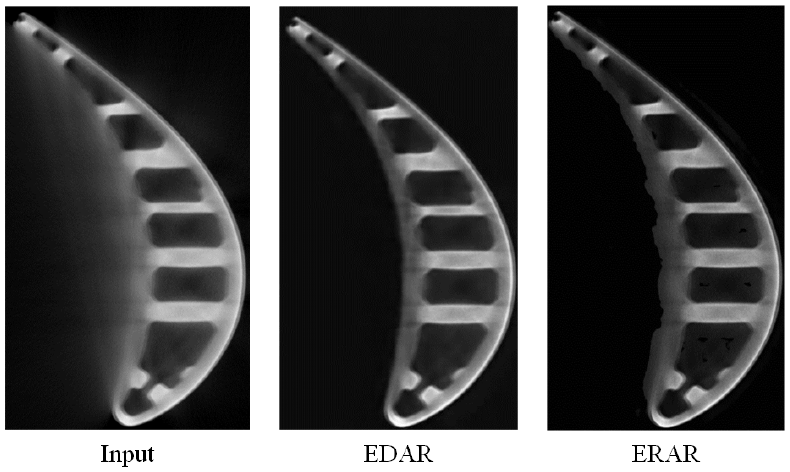
Figure 9. The visual results generated by ERAR and